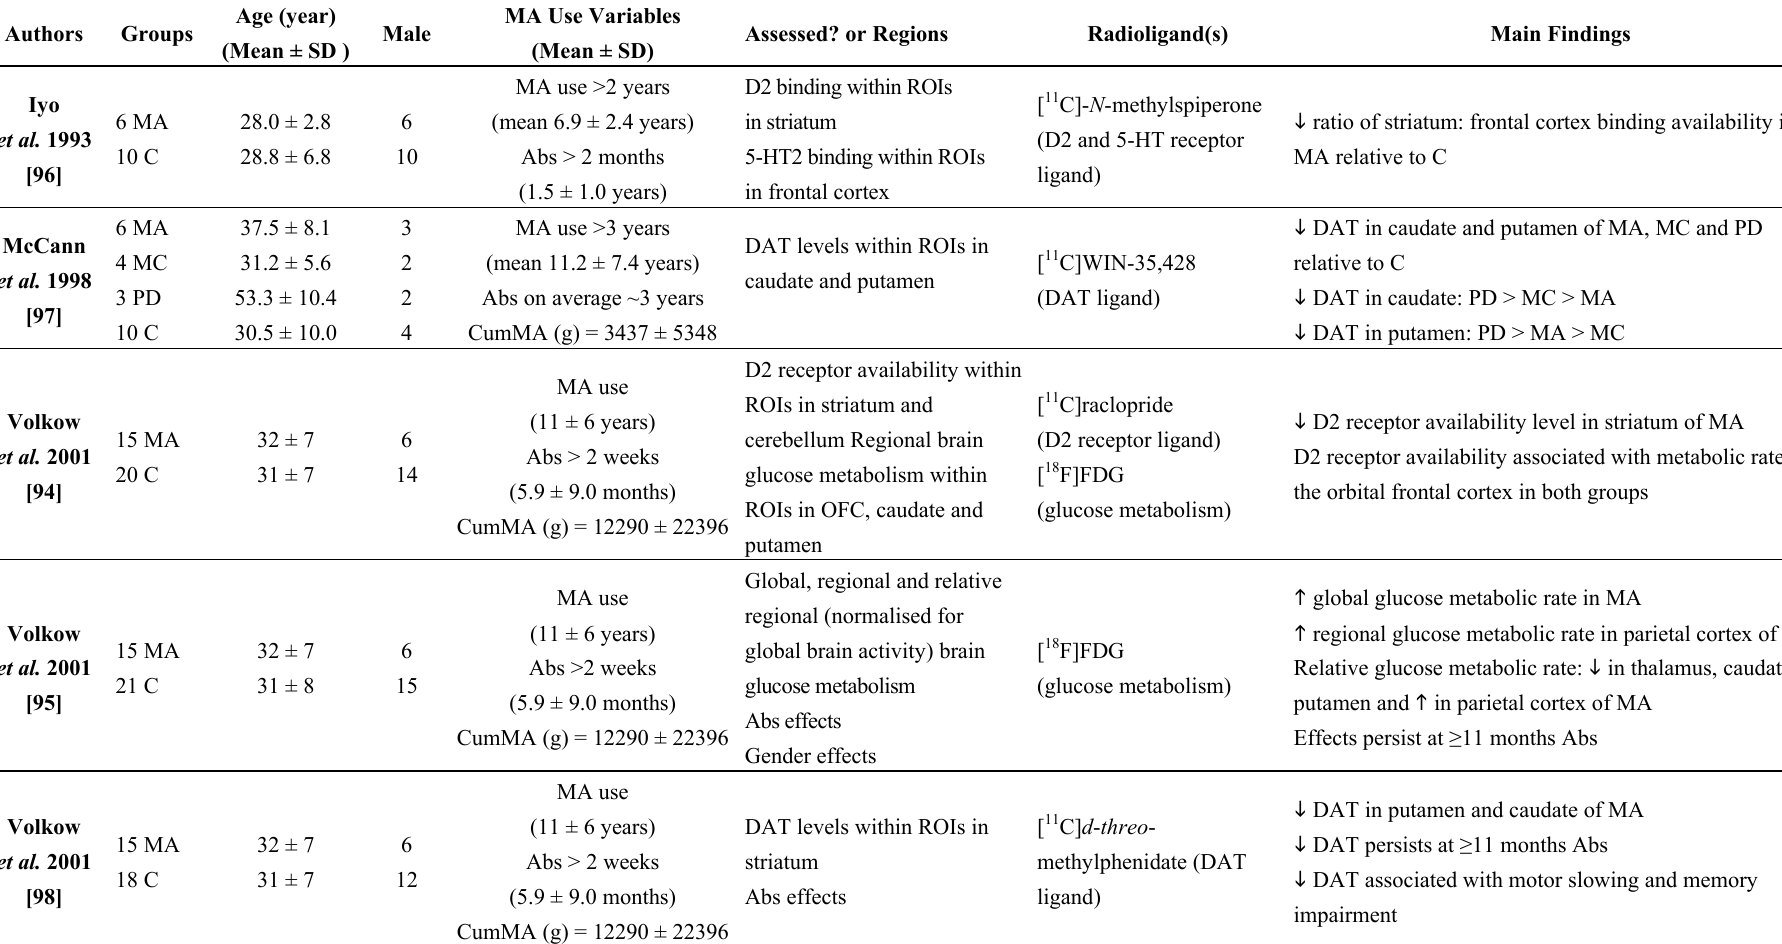
Table 1. Summary of study specifications and findings from PET studies of MA